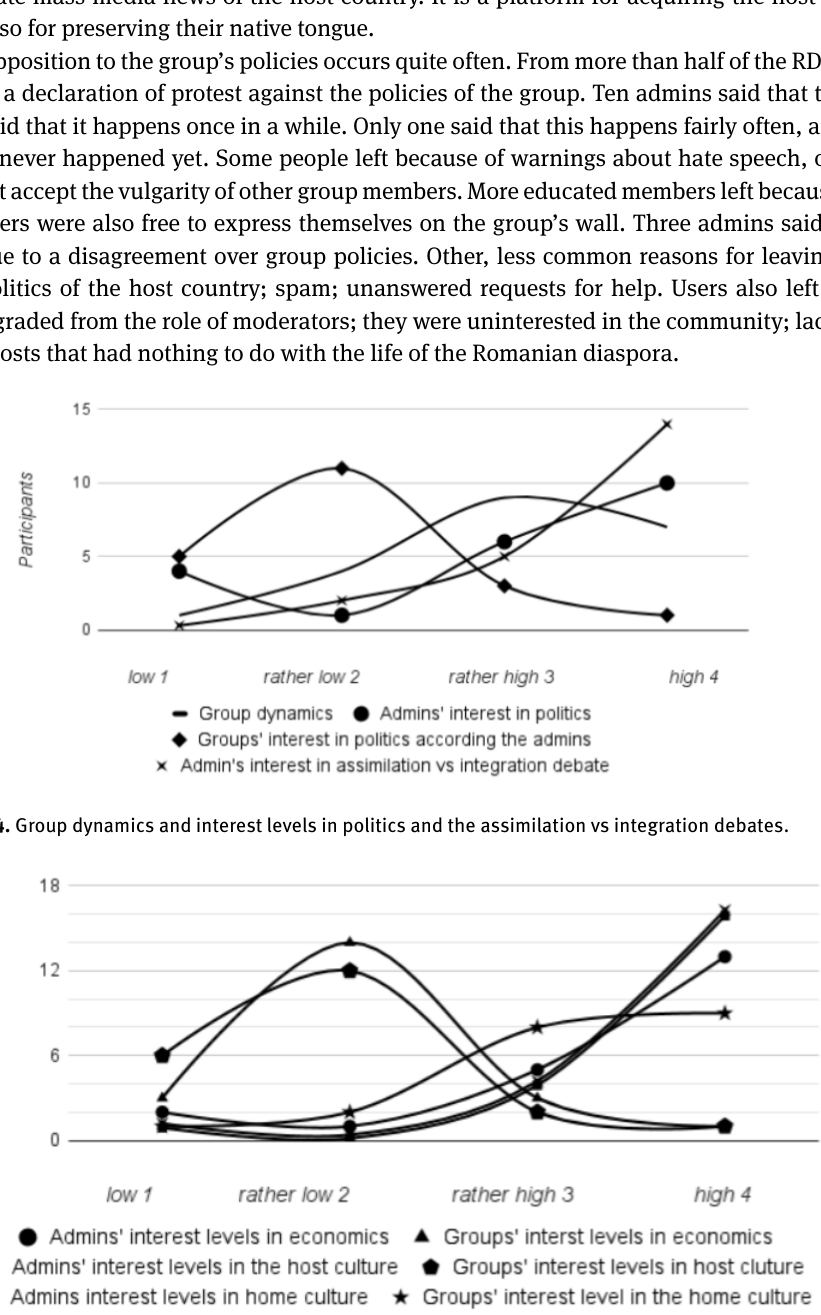
Figure 5. Admins and OMs interest levels in economics, host and home